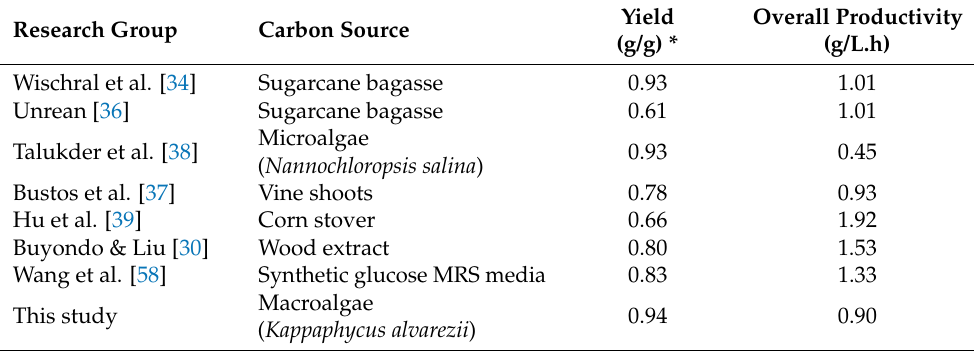
Table 7. Lactic acid production by L. pentosus from different raw material reported in literature.